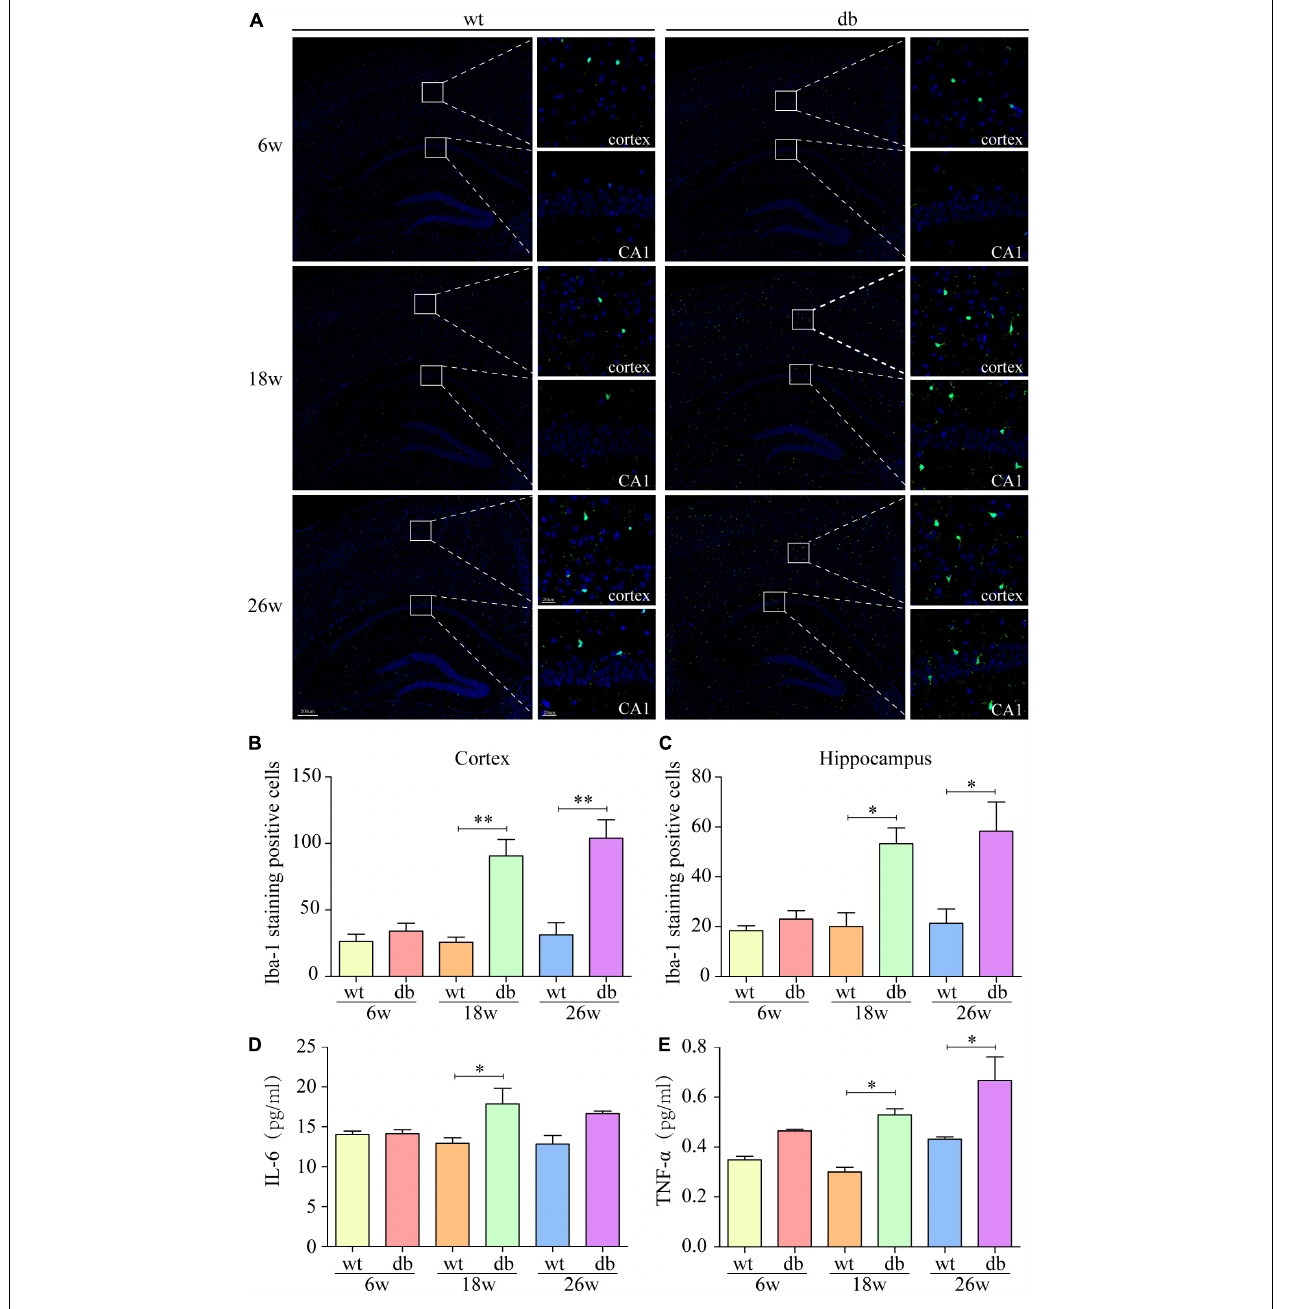
FIGURE 4 | Increased microgliosis and pro-inflammatory cytokines in db/db mice with age. (A) Representative immunofluorescent staining of Iba-1-positive microglia in the cortex and hippocampus of mice. Scale bar = 200 or 20 µ m. (B,C) Quantification of Iba-1-staining positive cells within the cortex or the hippocampus. (D,E) MSD was performed to detect the protein levels of IL-6 and TNF- α . ( n = 3 per group); ∗ P < 0.05; ∗∗ P < 0.01.